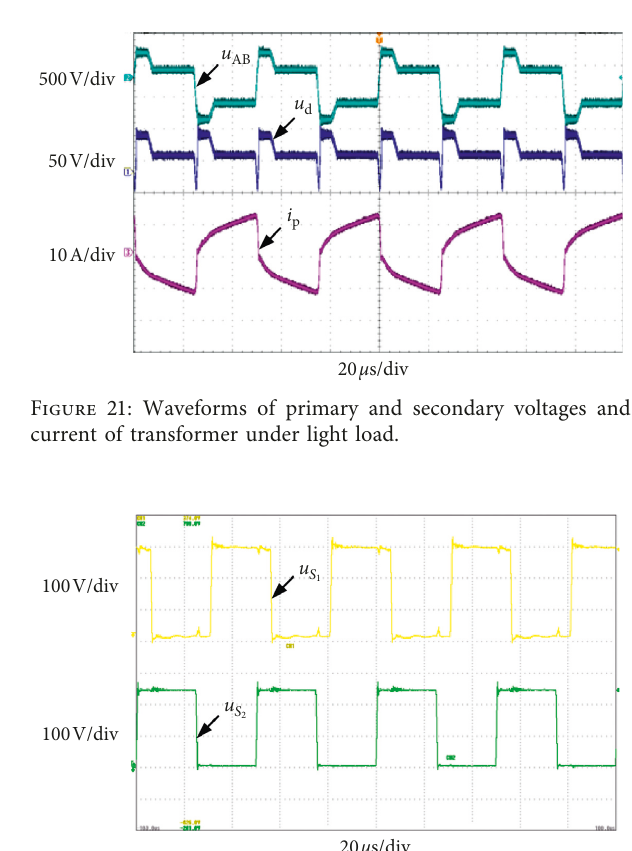
Figure 22: Voltage waveforms at two ends of S